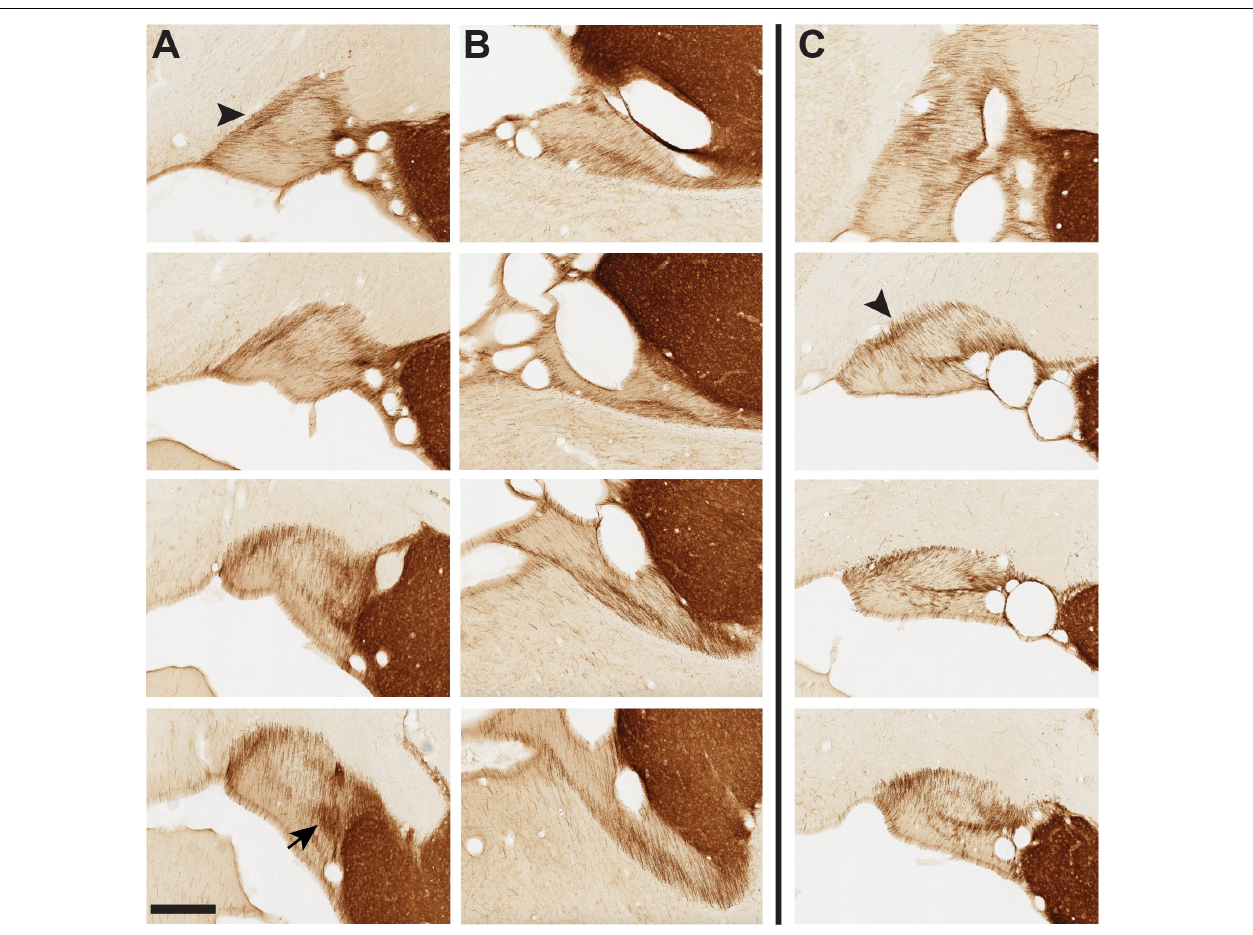
FIGURE 8 | Tyrosine hydroxylase+ (TH+) fibers in panel (A) vST of infant brain 61, panel (B) dST of infant brain 61, and panel (C) vST of infant brain 65. Brain 61 is typical of our sample, where TH + fibers form a semi-circumferential band in the vST, especially prominent at the medial edge [arrowhead in panel (A) ], with dorsal and ML components. The arrow at the bottom of row (A) indicates a concentrated neuropil aggregate at posterior levels (cf. Figure 4 ). (C) In brain 65, unusually, the gross orientation of the vST is rotated such that the medial band is now dorsal (arrowhead). A distinct pattern of TH + fibers remains evident, with a second ML band at the mid-portion of the vST. For dST in brain 65, there is an intricate fiber architecture, but dissimilar to the more typical pattern in the other three infant brains (see MacBrain data set for brain 65, sections 33–43). Anterior sections are at the top, with a posterior progression toward the bottom of each row. Medial is at the left. Scale bar = 350 µ